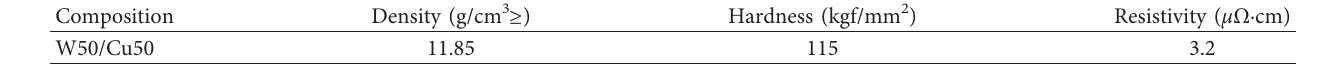
Table 2: Typical properties of commonly used copper tungsten compositions.